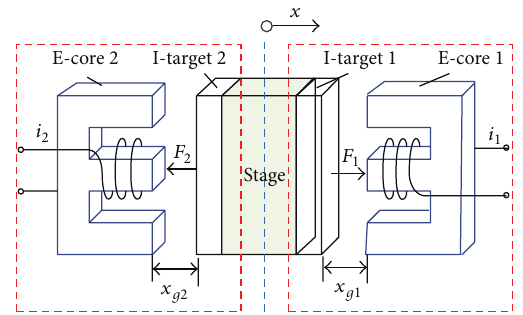
Figure 9: E/I-core type actuator